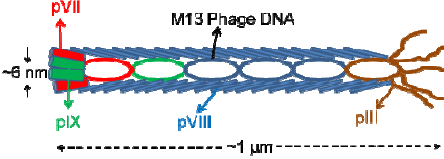
Figure 1. M13 phage with the coat proteins represented (note that the image is not drawn in scale).